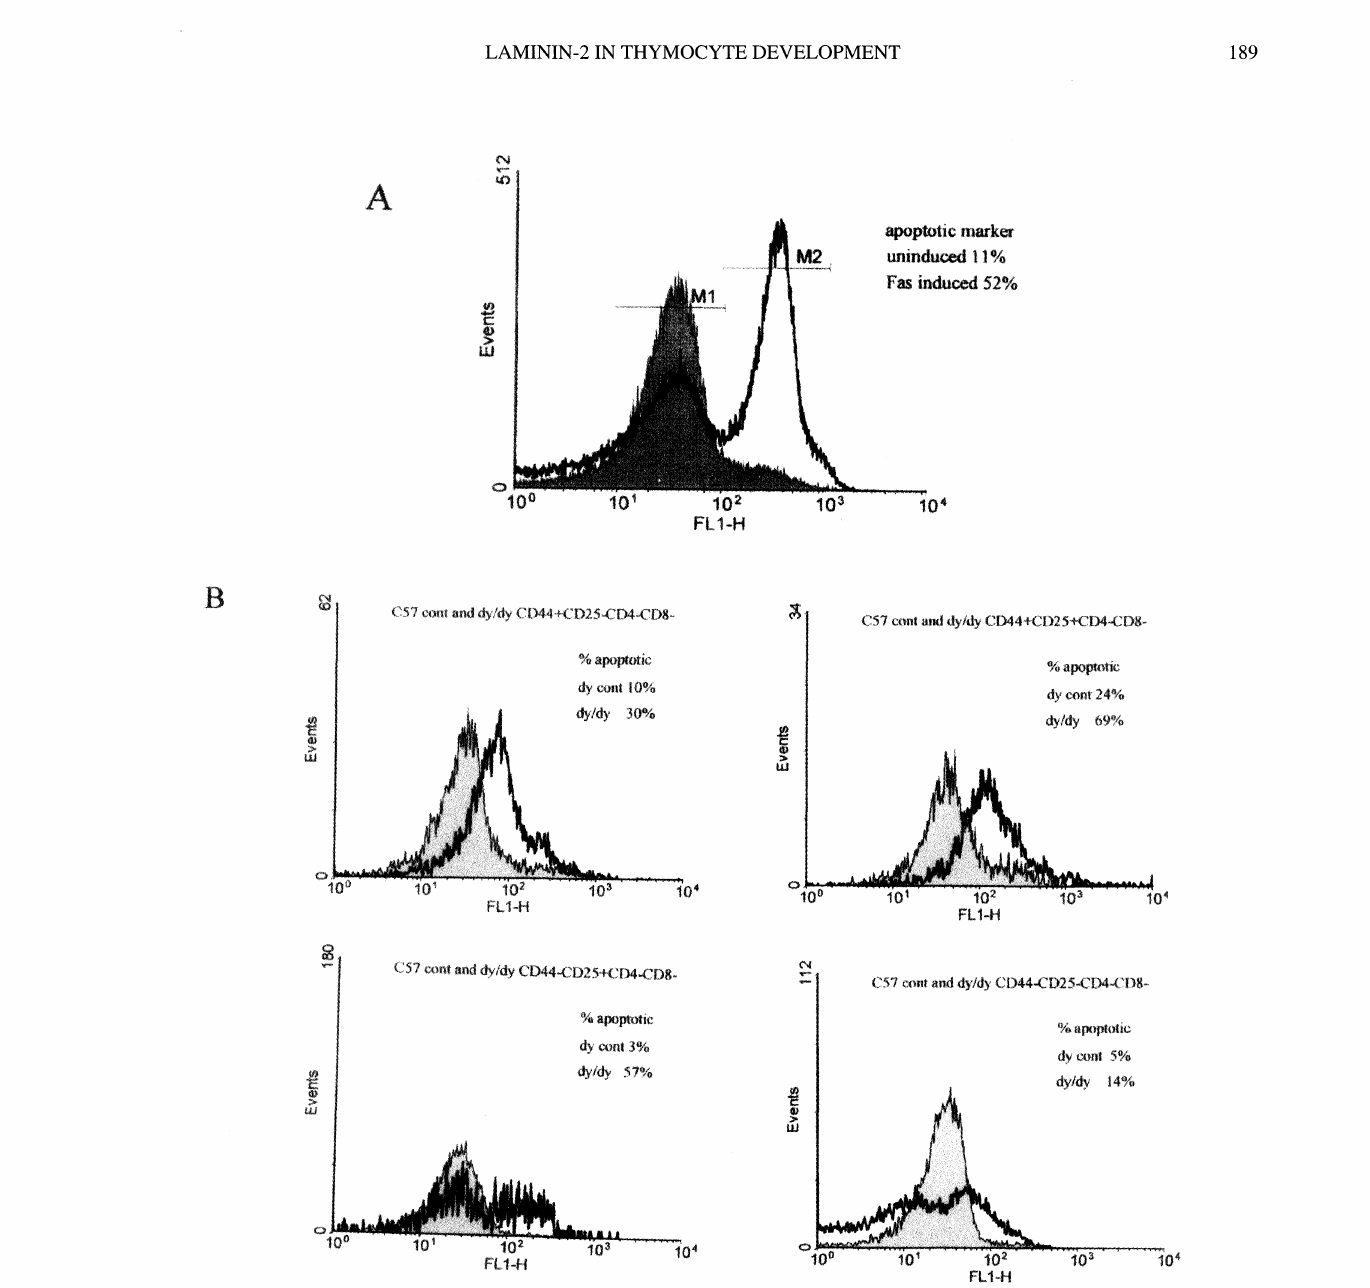
FIGURE 5 Combined flow cytometry and flow cytoenzymology define apoptotic thymocyte populations. To characterize apoptotic thy- mocyte populations, thymocytes isolated from dystrophic and control mice were stained with antibodies to thymic subset markers and ana- lyzed by flow cytometry and flow cytoenzymology. The DEVD-Caspase 3 substrate (Coulter Corp.) releases a fluorophore readable on FL1 when the substrate is cleaved by caspase 3. Cell viability and surface markers were analyzed on FL2, FL3, and FL4 by typical flow